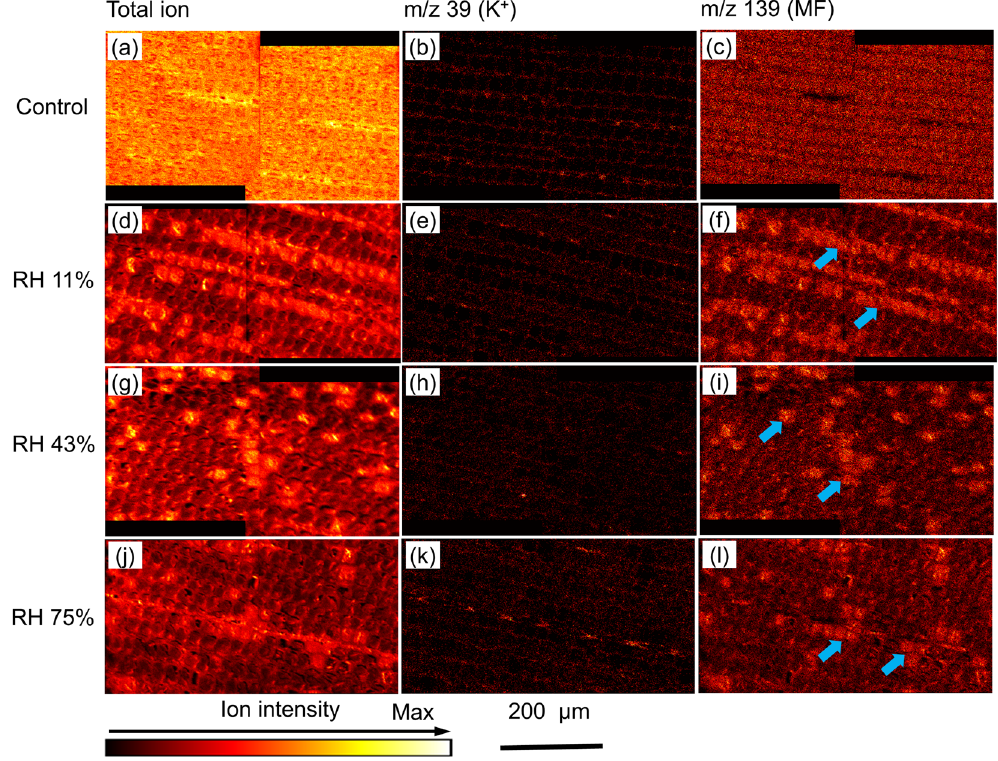
Figure 3. Cryo-TOF-SIMS images of the freeze-fixed MF-impregnated wood without conditioning ( a – c ; control), and with conditioning at RH of 11% ( d – f ), 43% ( g – i ), and 75% ( j – l ). The images of the total ion, m/z 39 (K + ), and m/z 139 (MF) are shown. Arrows indicate the cell cavities filled with